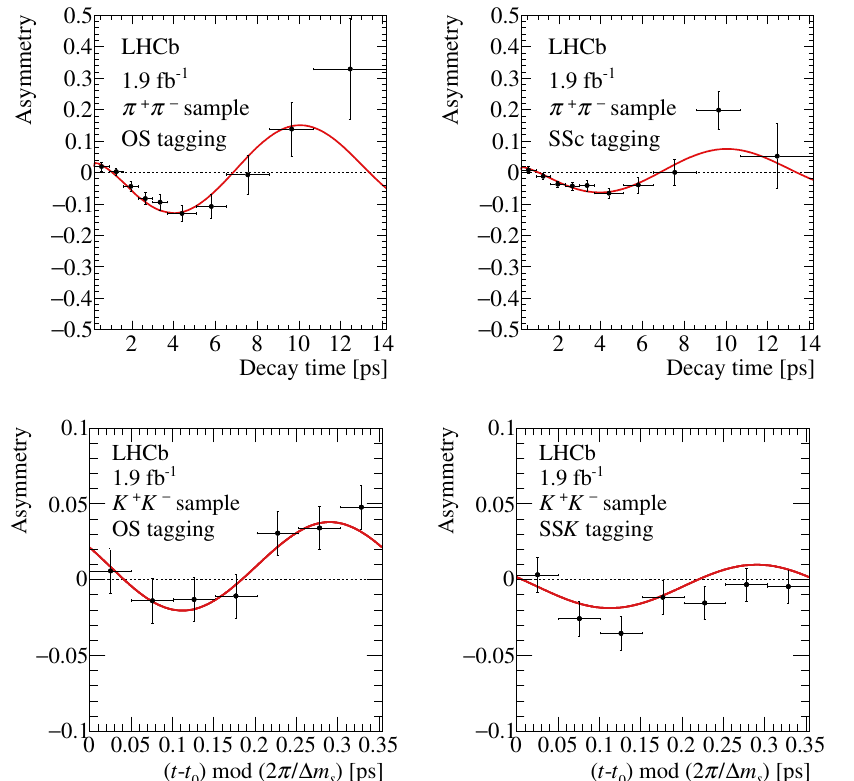
Figure 6 . Time-dependent asymmetries for (top) (cid:25) + (cid:25) (cid:0) and (bottom) K + K (cid:0) candidates with 5 : 20 < m ( (cid:25) + (cid:25) (cid:0) ) < 5 : 35 GeV/ c 2 and 5 : 30 < m ( K + K (cid:0) ) < 5 : 44 GeV/ c 2 , respectively: (left) using the OS-tagging decision and (right) using either the SSc-tagging decision (for the (cid:25) + (cid:25) (cid:0) candidates) or the SS K -tagging decision (for the K + K (cid:0) candidates). The result of the simultaneous (cid:12)t is overlaid. The asymmetry for the K + K (cid:0) candidates is folded into one mixing period 2 (cid:25)= (cid:1) m s and the parameter t 0 = 0 : 2 ps corresponds to the minimum value of the decay-time used in the